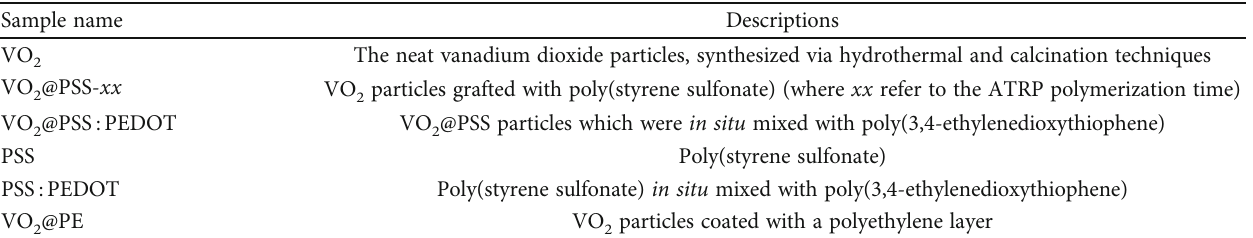
Figure 1: Schematic illustration of surface grafting of VO Table 1: List of abbreviation for the sample